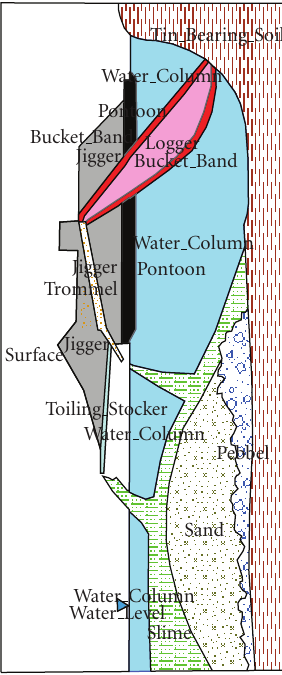
Figure 3: Dredge methods of mining [28].